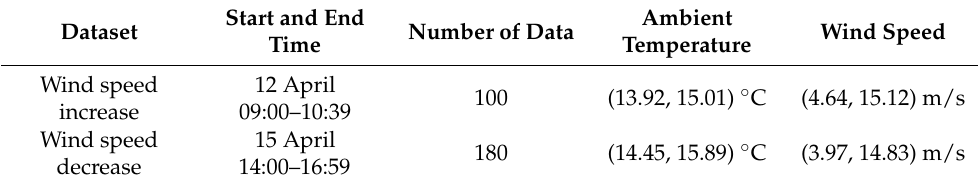
Table 5. Datasets of wind speed increase and